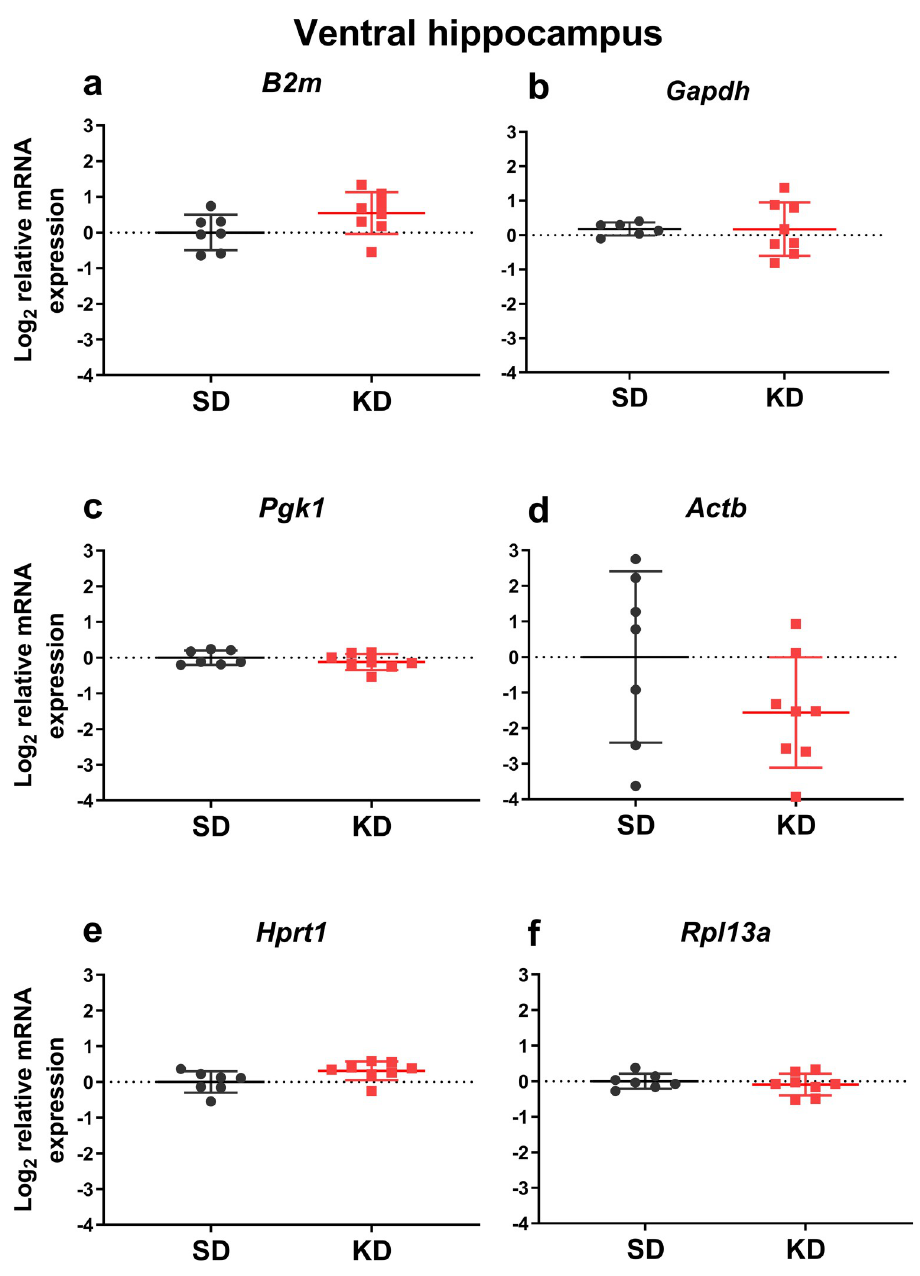
Fig 6. The effects of medium-chain triglyceride supplementation for 1 month on the mRNA expression of reference genes in the rat ventral hippocampal area. MCT (2 ml/kg body weight) were given as a supplement to standard feed to adult animals (9 m.o., BW = 444 ± 69 g) by oral gavage daily for 4 weeks (KD), while the control rats received equivolume water (SD). The mRNA expression was normalized to the geometric mean of the expression level of the three most stably expressed genes ( Ywhaz , Sdha , Ppia)